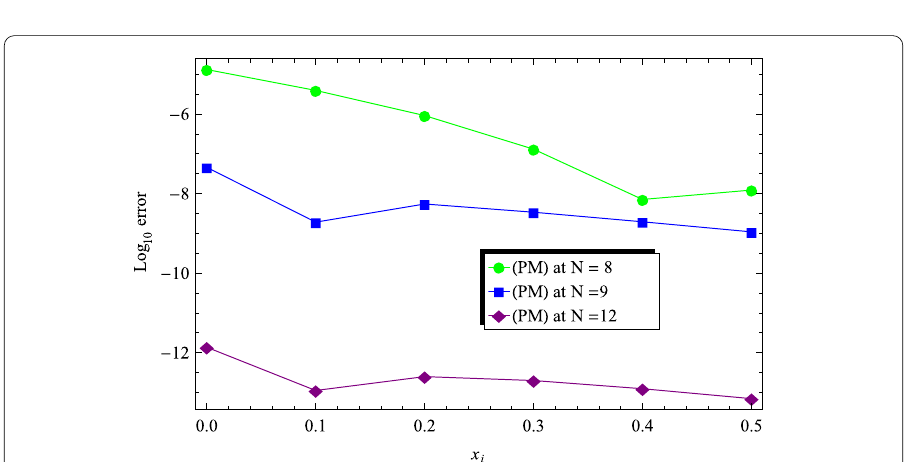
Figure 5 Comparison of error function for the present method at N = 8, N = 9 and 12 for Example 5, where ν 4 =